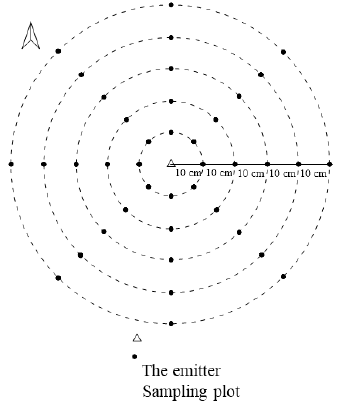
Figure 2. Distribution of soil salt crust (SSC) sampling plots around the drip irrigation emitter.